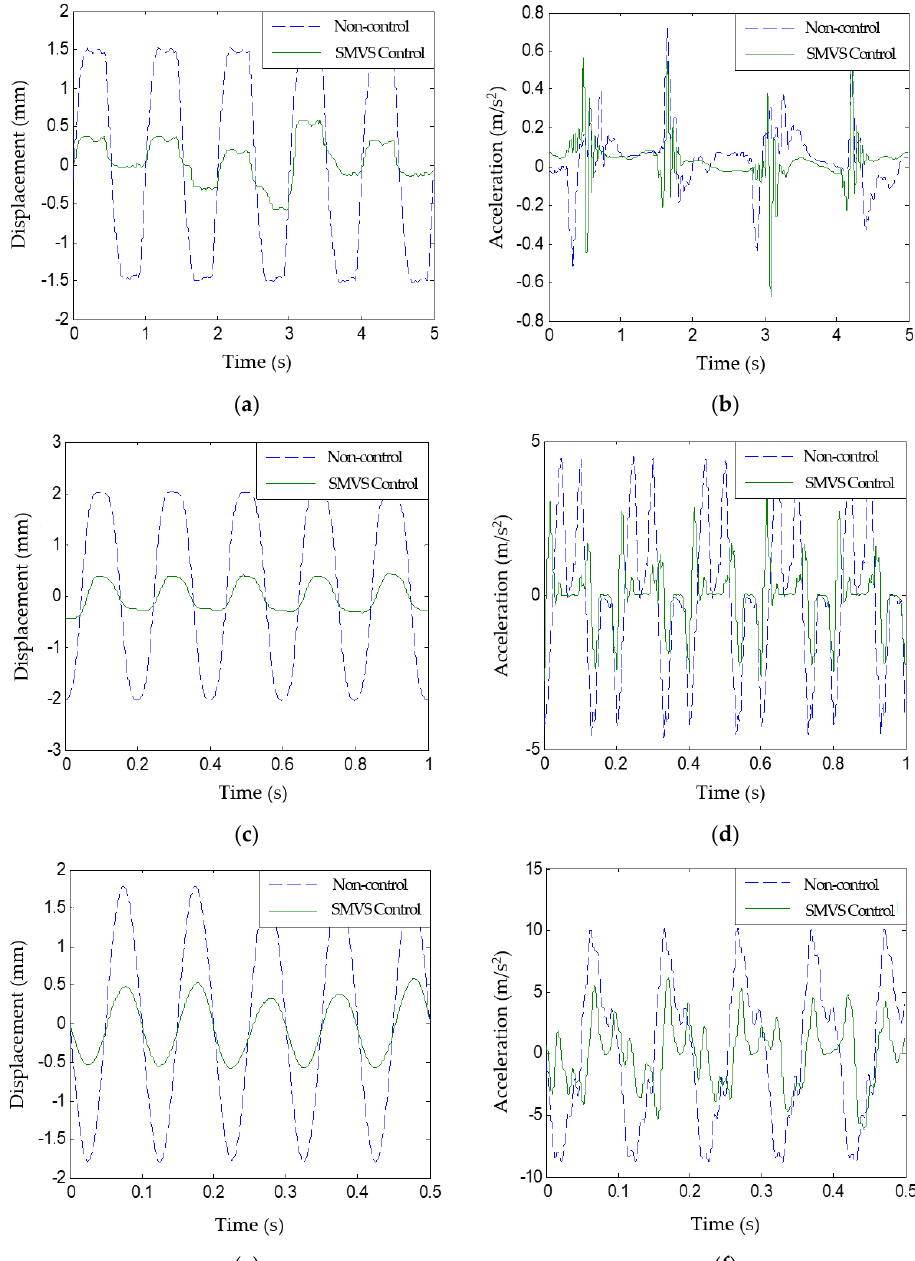
Figure 16. Pipeline vibration response under SMVS control and excitation frequency of 1, 5, 10 Hz: ( a ) Displacement-time curve (1 Hz); ( b ) Acceleration-time curve (1 Hz); ( c ) Displacement-time curve (5 Hz); ( d ) Acceleration-time curve (5 Hz); ( e ) Displacement-time curve (10 Hz); ( f ) Acceleration-time curve (10 Hz) Table 4. Vibration response of pipeline under SMVS control.